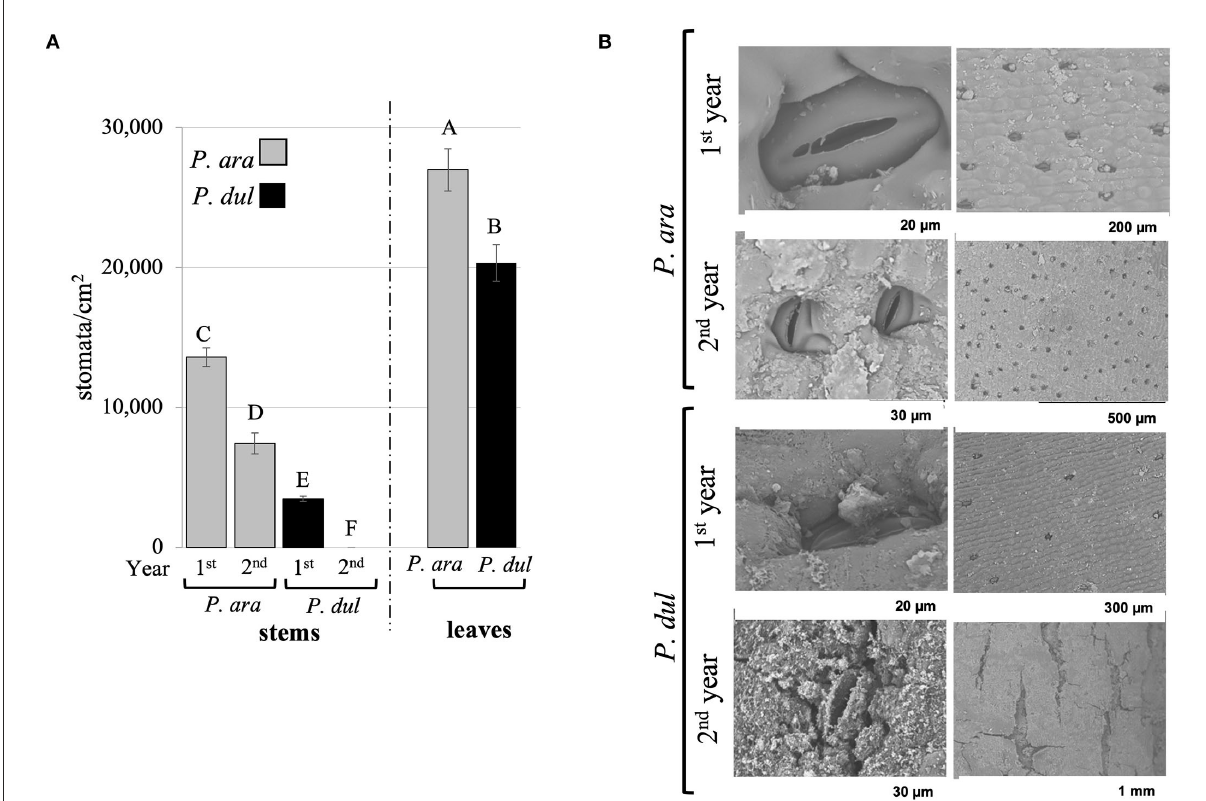
FIGURE2 Characterization of the stomata in P. arabica and P. dulcis stems and leaves. (A) Stomata quantification on P. arabica and P. dulcis stems and leaves. The number of stomata was measured in stems of the 1 st year (1 st year) and the second (2 nd year) and in leaves. Figure presents the mean ± SE of n = 30 1 st -year stems, n = 8 2 nd -year stems, and n = 11 leaves, in each almond species. Capital letters above columns represent statistically significant differences ( p < 0.05 t-test ). (B) Scanning electron microscope analysis of P. arabica and P. dulcis 1 st and 2 nd -year stems indicates sunken stomata in the green 1 st -year stems in both species. In addition, although stomata remained on adult stems of P. arabica , even in their 2 nd year, P. dulcis stomata were covered with cork. Representative images are